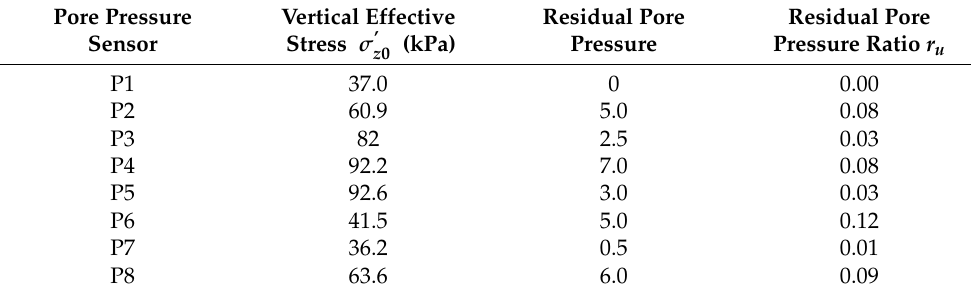
Table 2. Excess pore pressure ratio at P1 to P8 in Test